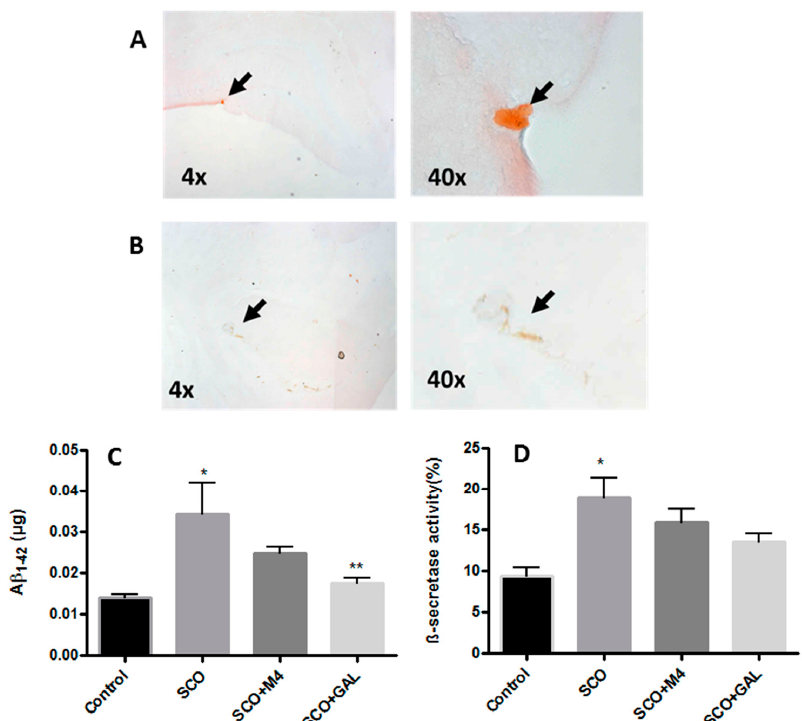
Figure 5. E ff ect of M4 compound and galantamine administered intraperitoneally on A β production observed by Congo red stained in the coronal brain sections and A β 1-42 and β -secretase activity quantification in the tissue of hippocampus. ( A ) Coronal section of brain samples obtained from rats treated with scopolamine plus M4 compound. ( B ) Coronal section of brain samples obtained from rats treated with scopolamine and galantamine. ( C ) A β 1-42 levels from the control samples, treated with scopolamine and scopolamine plus M4 compound or galantamine (* p < 0.05 vs. control; ** p < 0.05 vs. sco). ( D ) β -secretase activity from control samples, treated with scopolamine and scopolamine plus M4 compound or galantamine (* p < 0.05 vs. control). All experiment employed n = 8 and was done in triplicate.